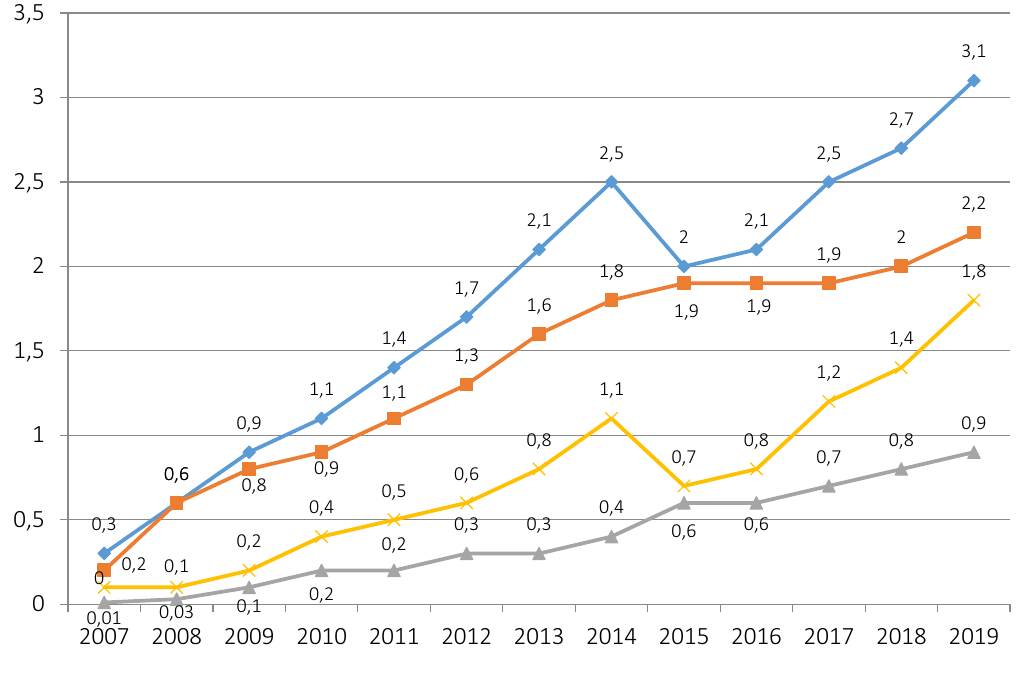
Figure 1. Dynamics of the total value of pension assets, the volume of pension contributions, pension payments, and return on investment of pension assets of